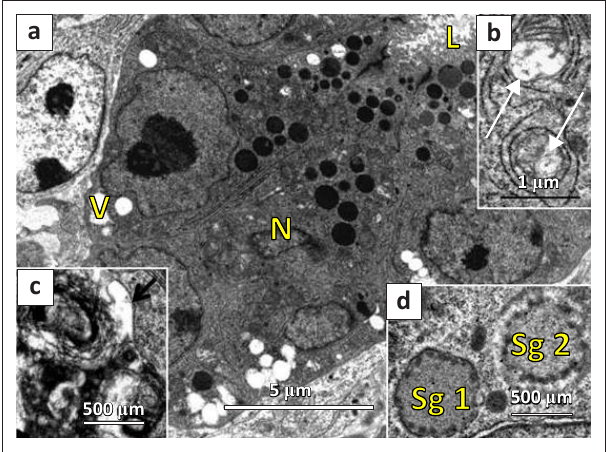
Thick arrows, swollen mitochondria; Thin arrows, dilated cisterns of RER; N, degenerating nucleus exhibiting membrane blebbing. FIGURE 9: Transmission electron micrograph of degenerating ciliated cell from a bird treated with carbendazim at a dose of 800 mg/kg bodyweight.